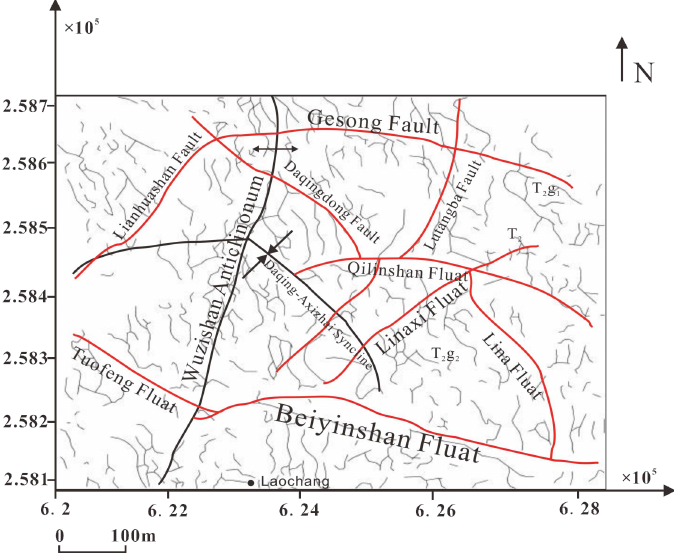
Figure 12. Artificial visual interpretation.